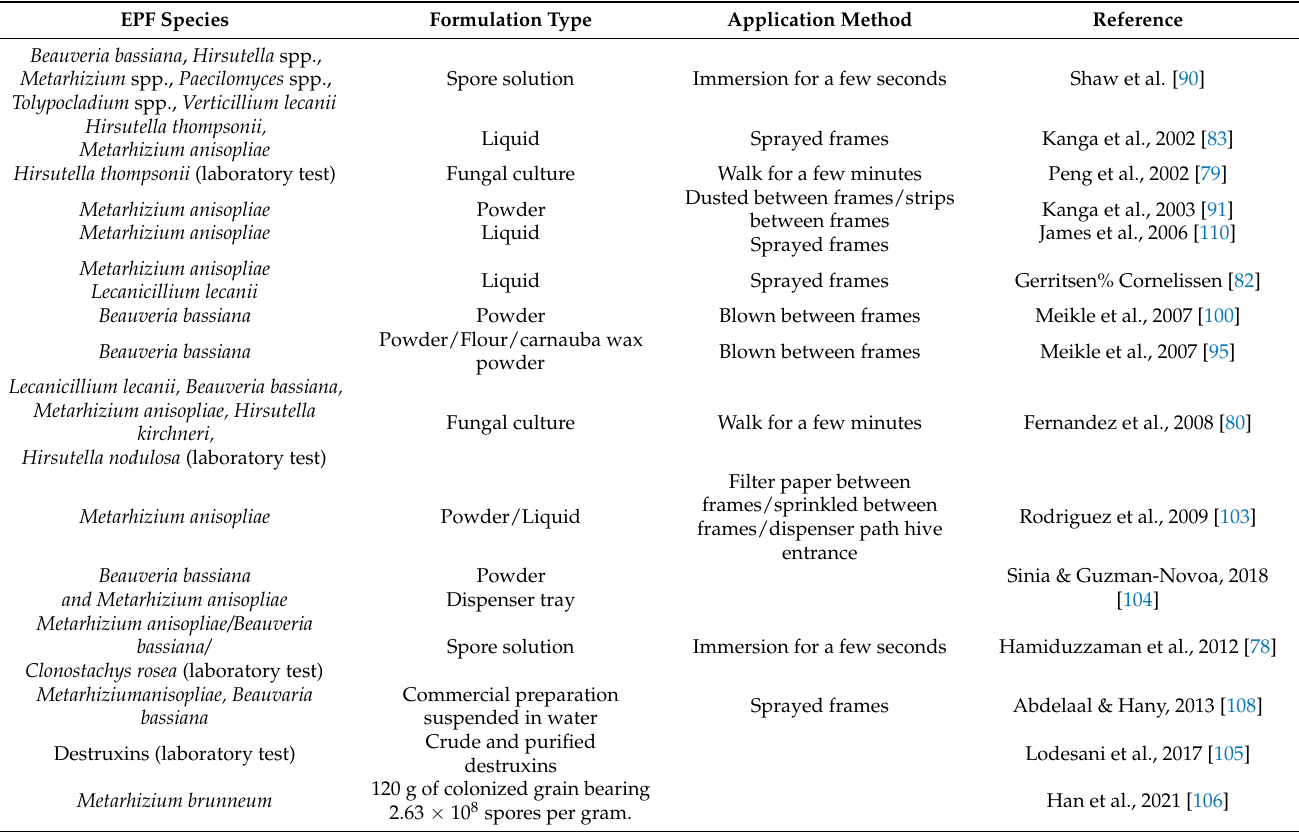
Table 1. Synoptic table of laboratory and field tests cited for Varroa destructor